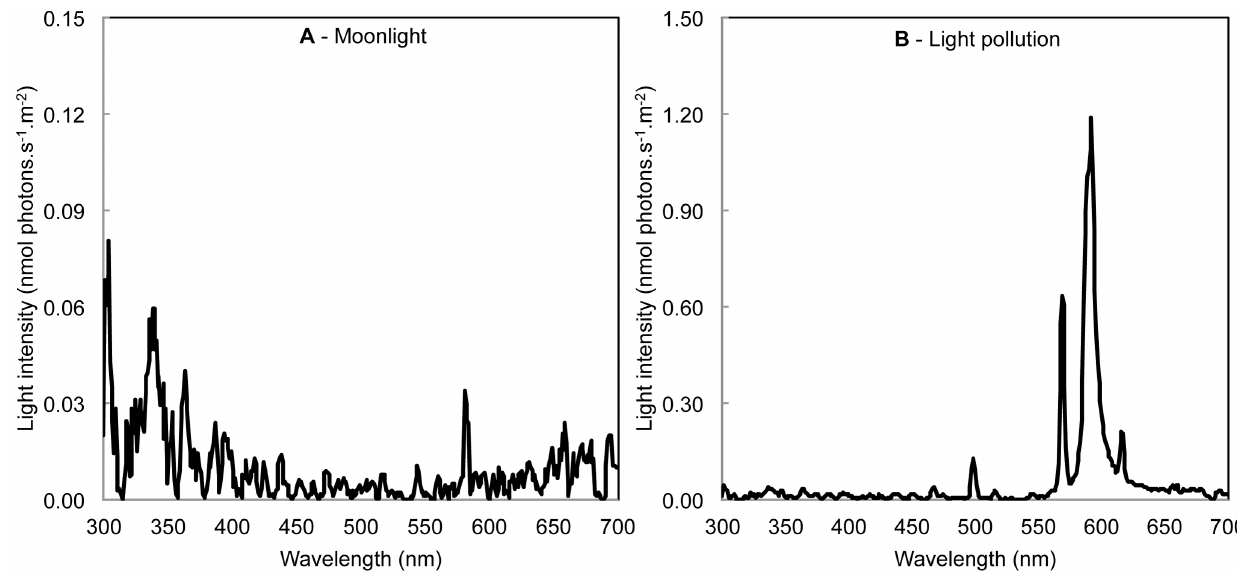
Figure 1. Differences in irradiance spectra of the lights used. To test the impact of urban light pollution on Microcebus murinus , we exposed animals to (A) moonlight treatment (light intensity: 3.9 6 0.1 nmol photons.s 2 1 .m 2 2 ); then to (B) light pollution treatment (light